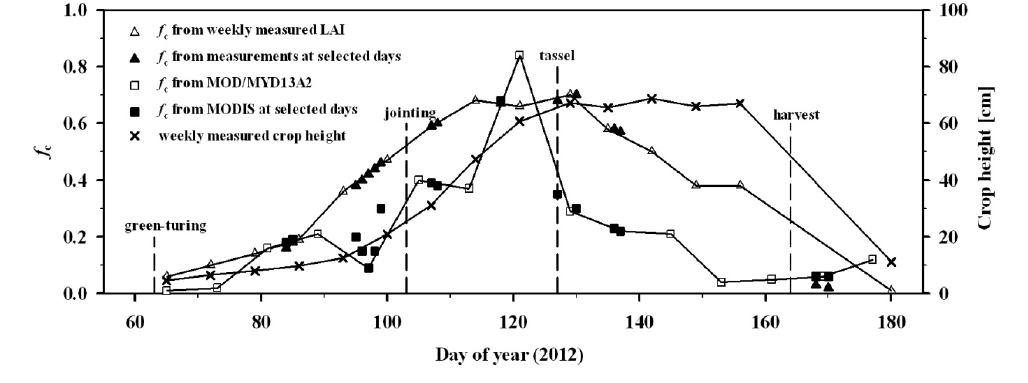
Figure 11. Surface characteristics of the Yucheng station during the wheat growth period in